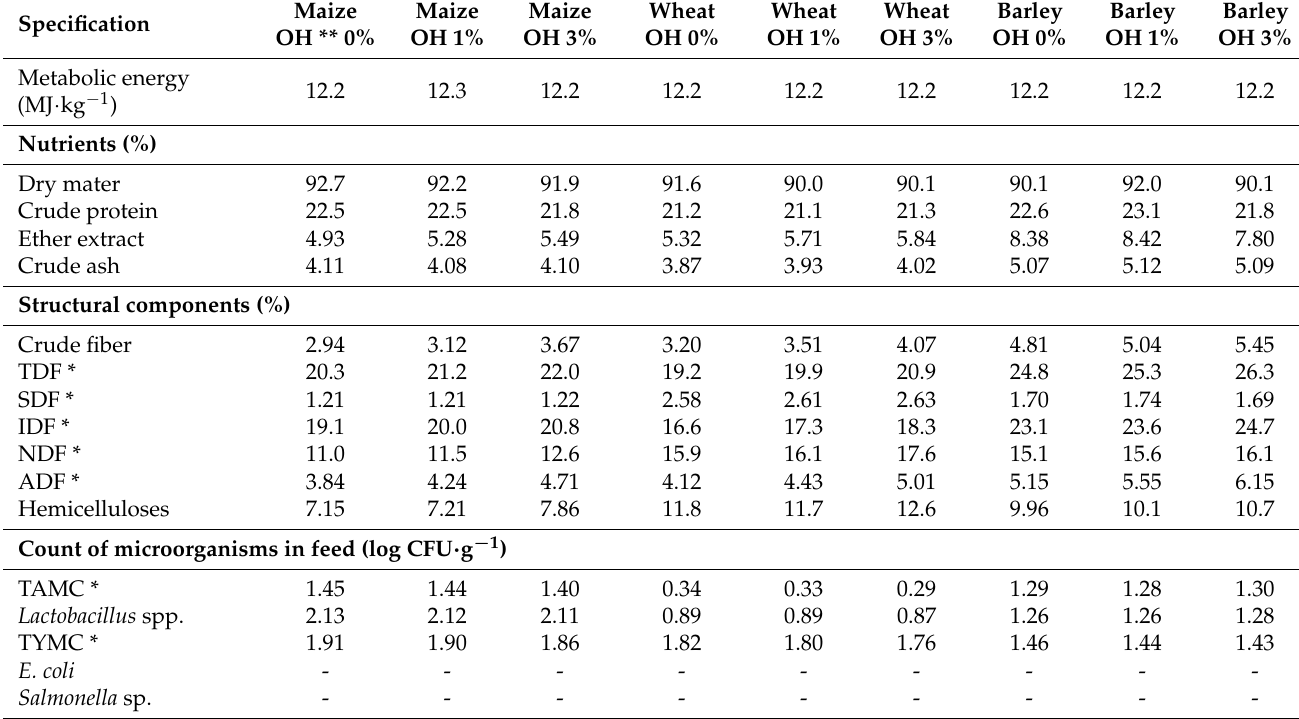
Table 2. Chemical composition of experimental